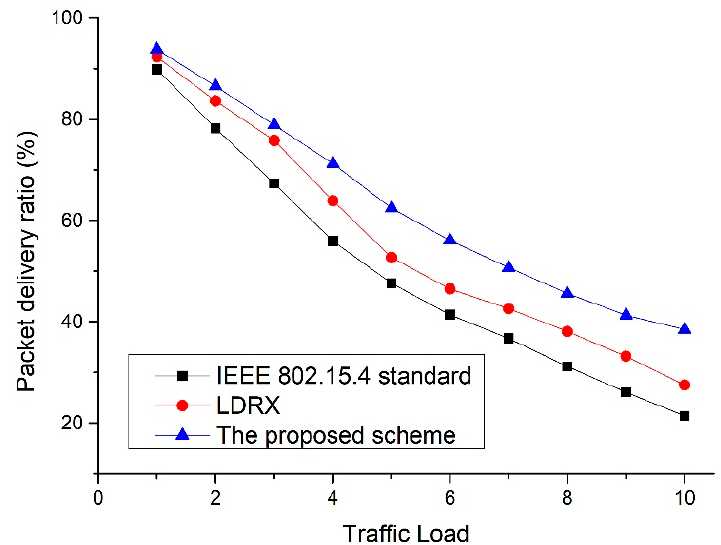
Figure 14. Packet delivery ratio as a function of traffic load.